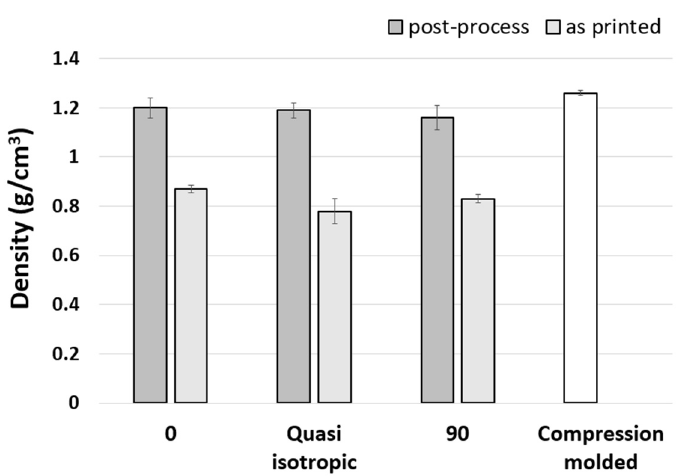
Figure 2. Density of each specimen type, before and after treatment compared with compression- molded samples.